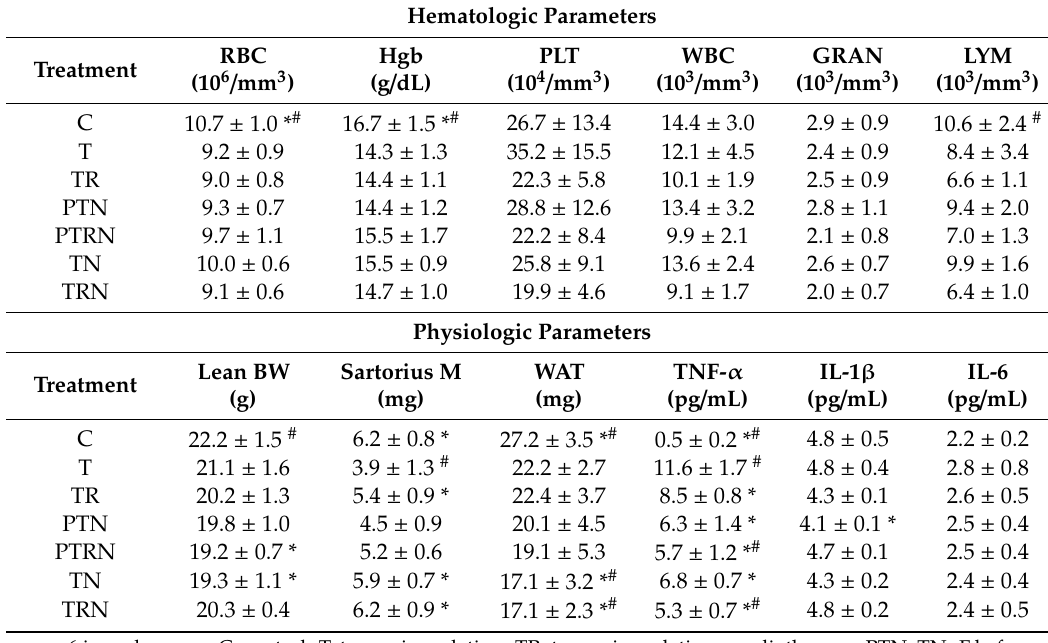
Table 1. E ff ect of the TNuF total nutrition formula on hematologic and physiologic parameters. Hematologic